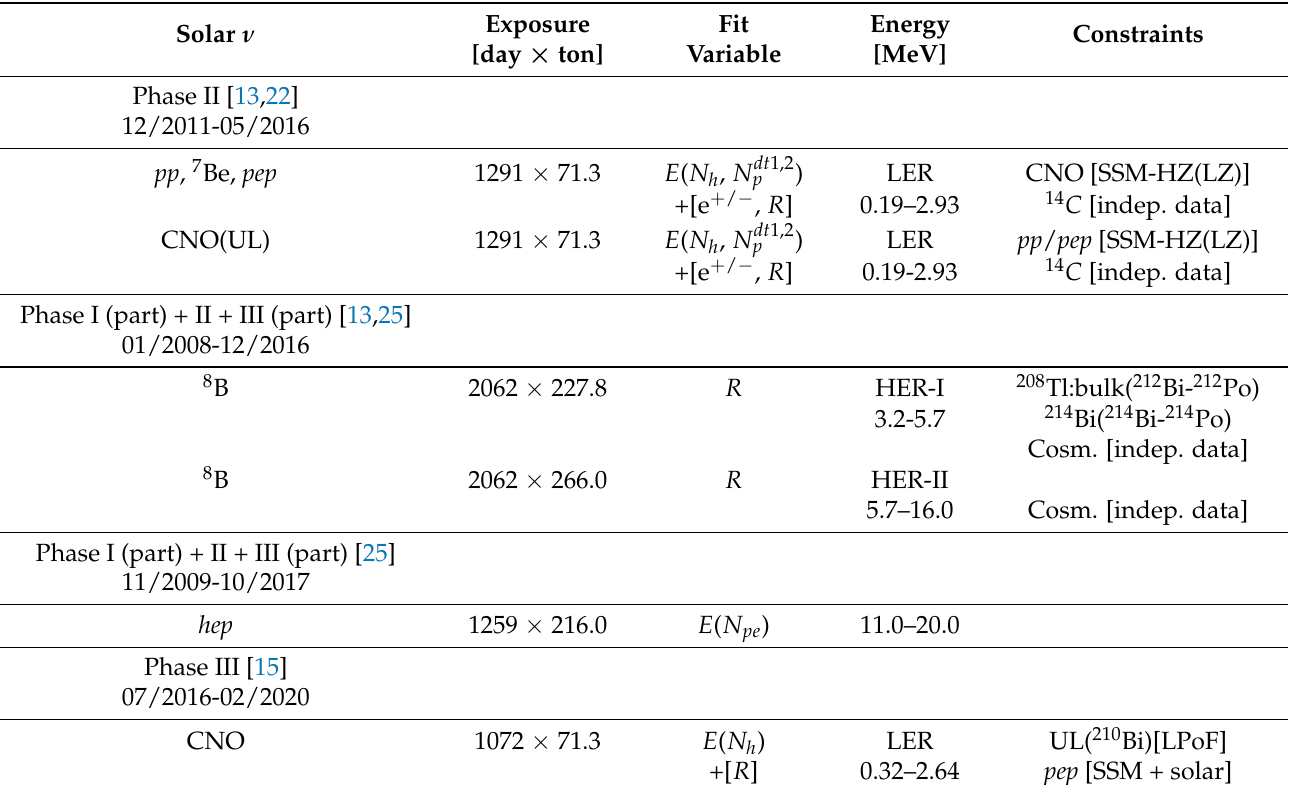
Table 4. Details of the solar neutrino analysis of the Borexino Phase II(+I) and Phase III data. The first column specifies the solar neutrino species extracted by the fit of the data using the exposure mentioned in the second column. The third column shows the variables used in the fit: global variable E , standing for various energy estimators (Section 2.2) or R , reconstructed radius. The parameters in square brackets identify the variables used in the multivariate part of the fit in the LER: pulse-shape variable used to constrain residual 11 C( e + ) and radial distribution constraining external background. The fourth column gives the energy range of the global variable, while the last column highlights the species whose rates were constrained in the fit. The source of information used to extract these independent constraints is given in brackets, while more details are given in text. UL = Upper Limit; Cosm. = cosmogenic background; indep. data = independent data; LER/HER = low/high-energy region; LPoF = Low Polonium